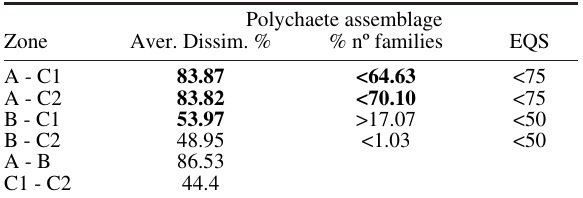
Table 3. – Summary of SIMPER dissimilarities of polychaete as- semblages in the four zones, A, fish farm; B, intermediate; C1, control 1; C2, control 2. Aver. Dissim, average dissimilarity. % nº families, percentage of the polychaete families in A and B in comparison with C1 and C2. EQS, environmental quality standard proposed by JACUMAR EMP.